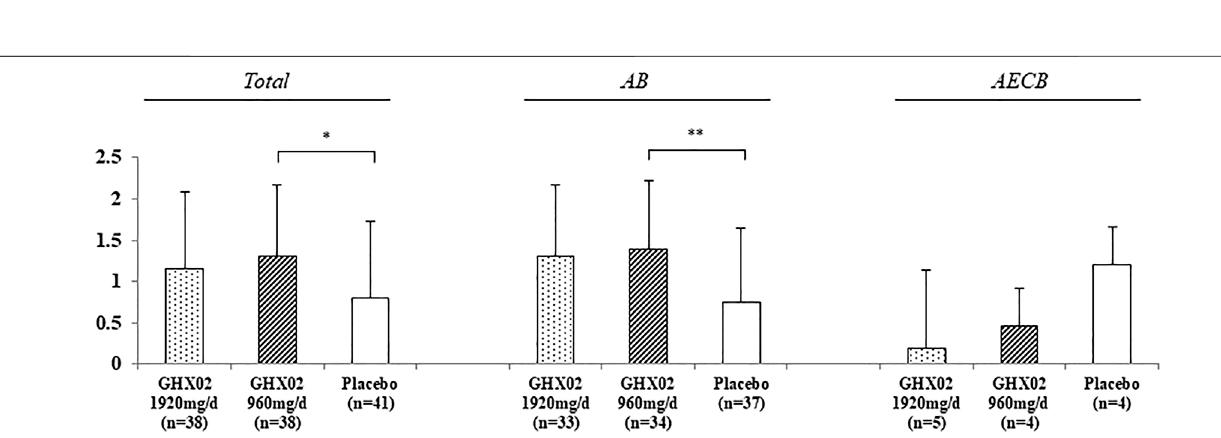
FIGURE 3 | Change of Frequency of coughing fi ts from Day 1 to Day 7. Results are expressed as mean ± SD with 95% con fi dence intervals (CIs) in FAS analysis. p -values indicate signi fi cance of mean differences in the value between groups (* p < 0.05, ** p < 0.01, and *** p < 0.001). AB, Acute Bronchitis; AECB, Acute Exacerbations of Chronic